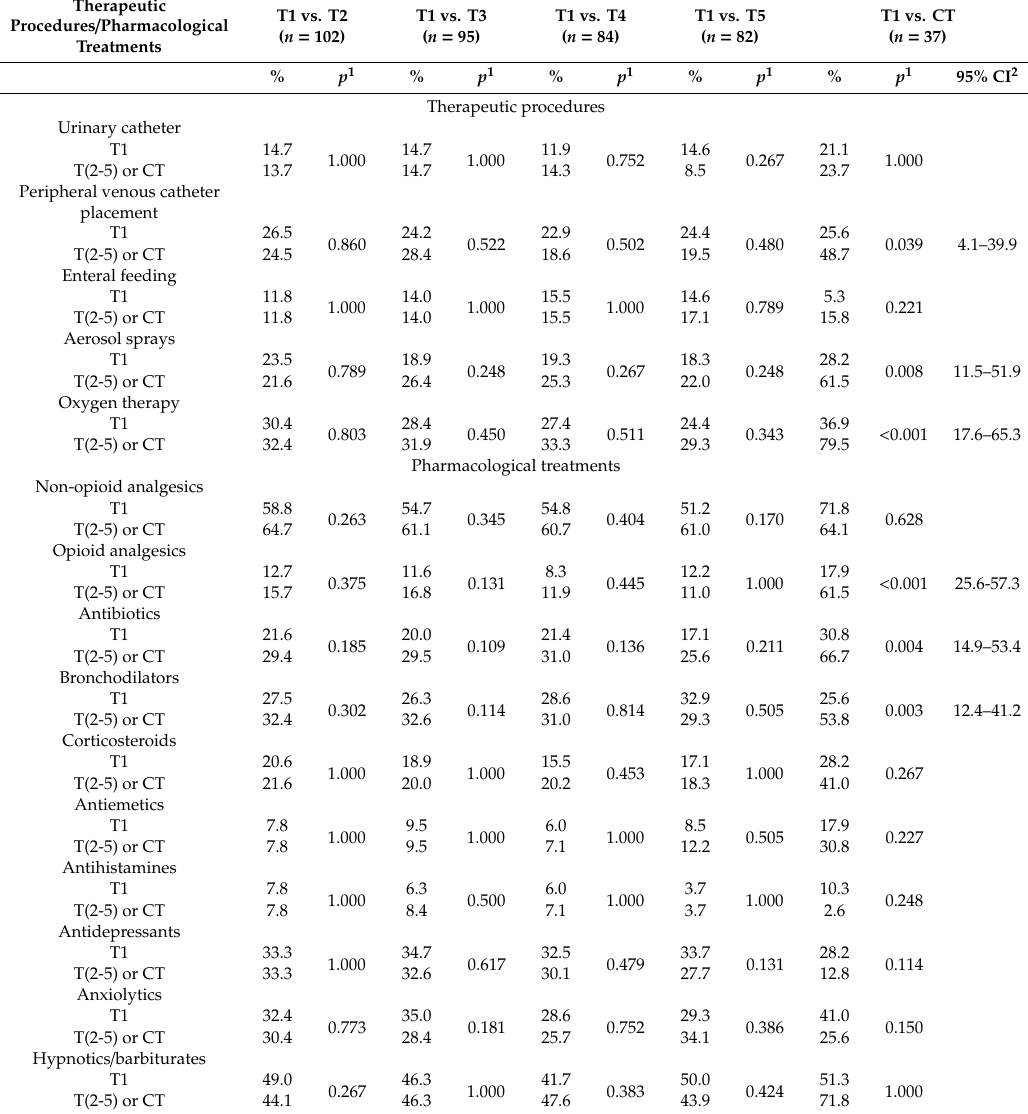
Table 4. Comparison of therapeutic procedures and pharmacological treatments by months for patients in nursing